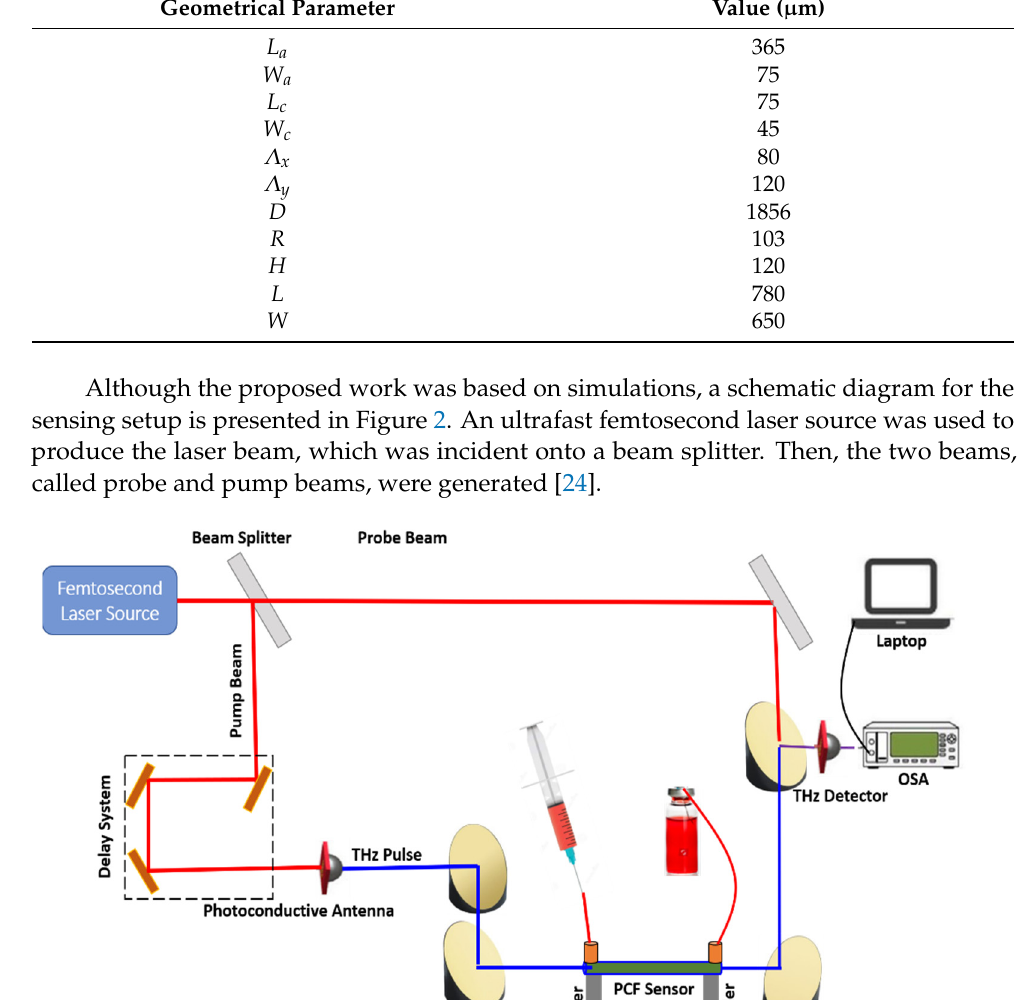
Table 1. The initial geometrical parameters of the proposed biosensor design. Figure 1. ( a ) 2D cross-sectional diagram; ( b ) 3D view of the suggested biosensor.